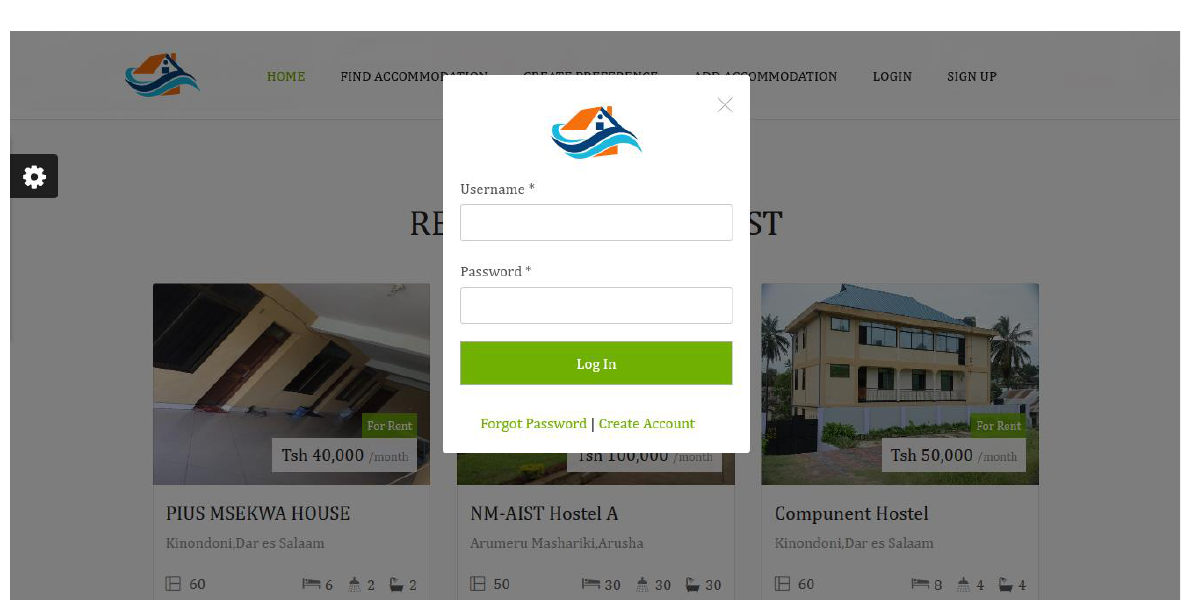
Figure 11. User Registration Form